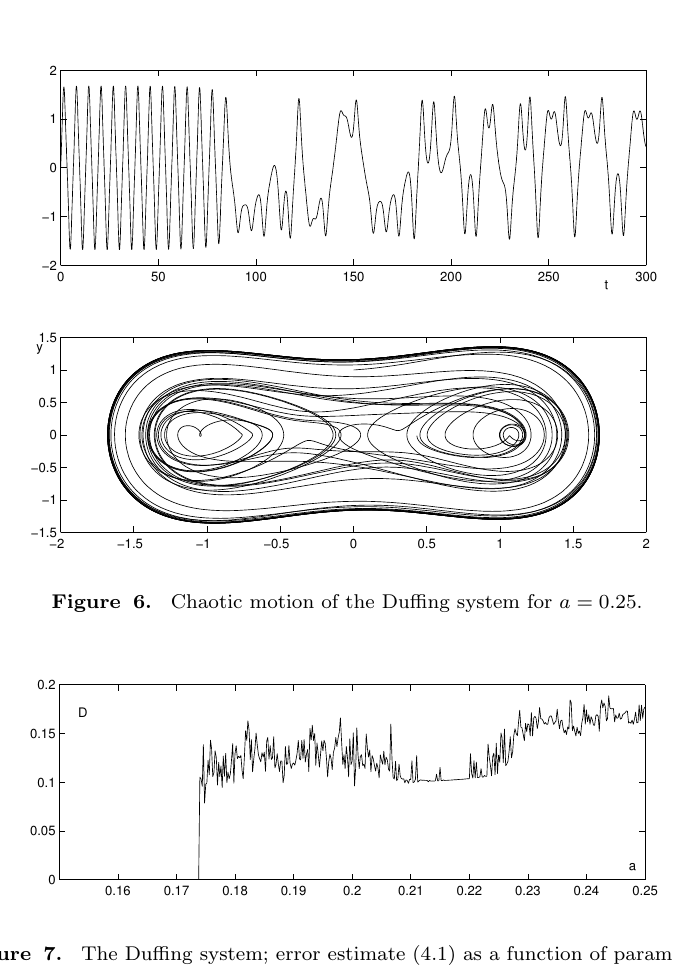
Figure 7. The Duffing system; error estimate (4.1) as a function of parameter a